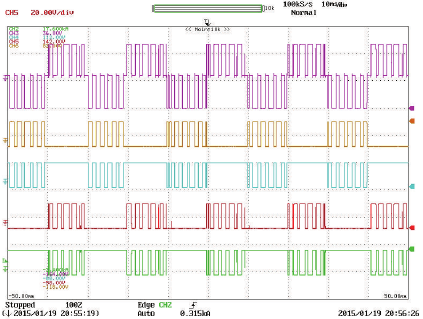
Figure 25: Inverter output voltage and output gate pulses for single phase bridge